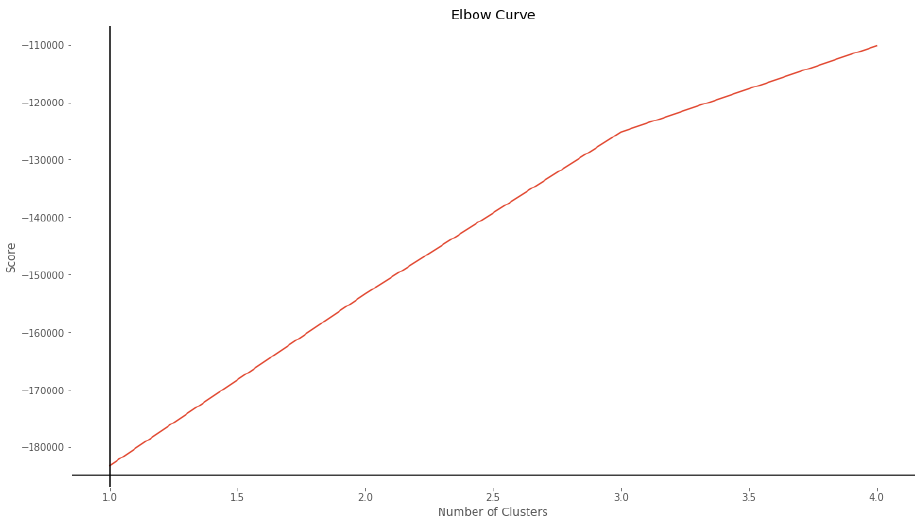
Figure 3. Elbow curve.